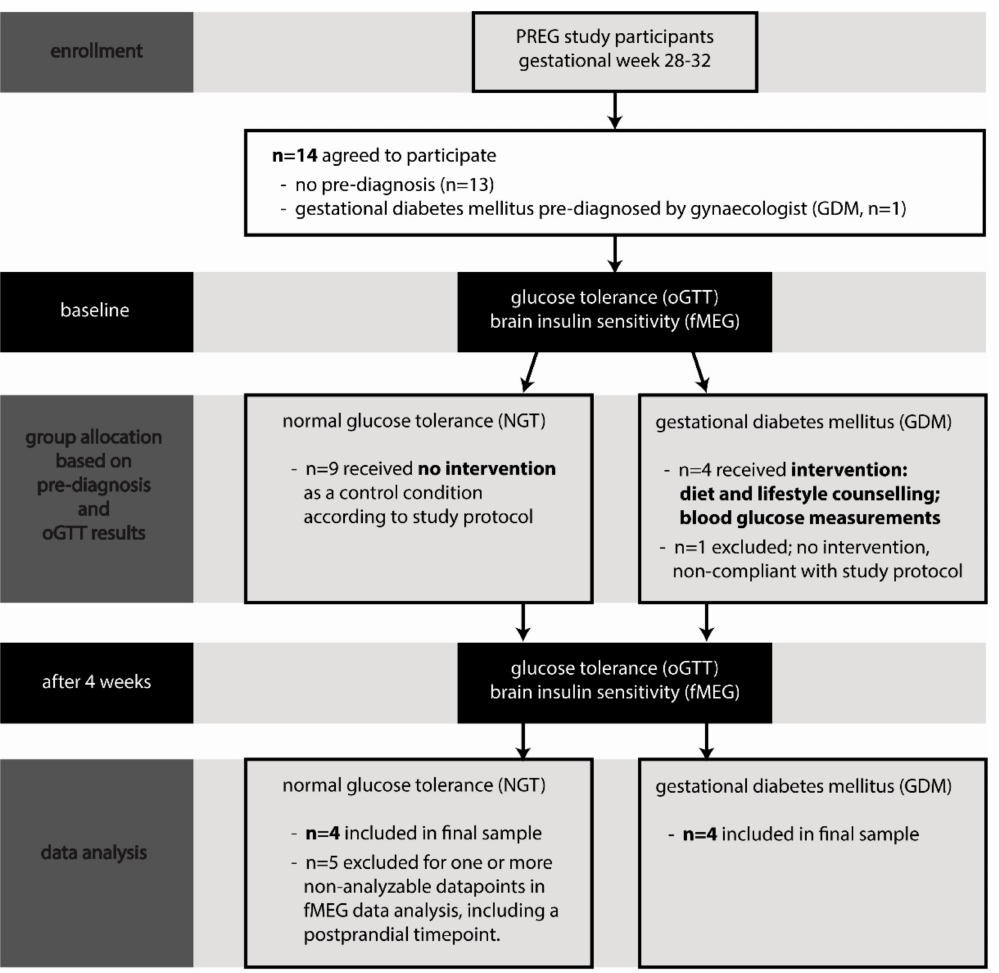
Figure 1. Flow diagram of the course of the